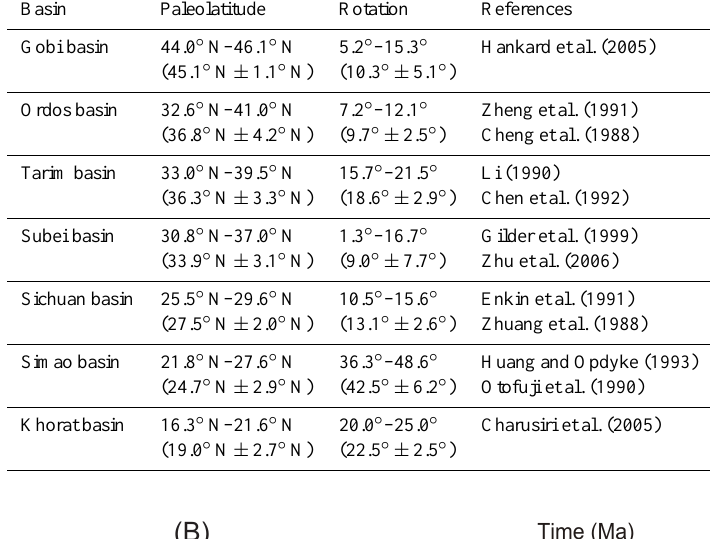
Table 1. Paleoposition of the Cretaceous eolian sandstones in Asia. Paleolatitudes and rotations of the basins are based on paleomagnetic data.